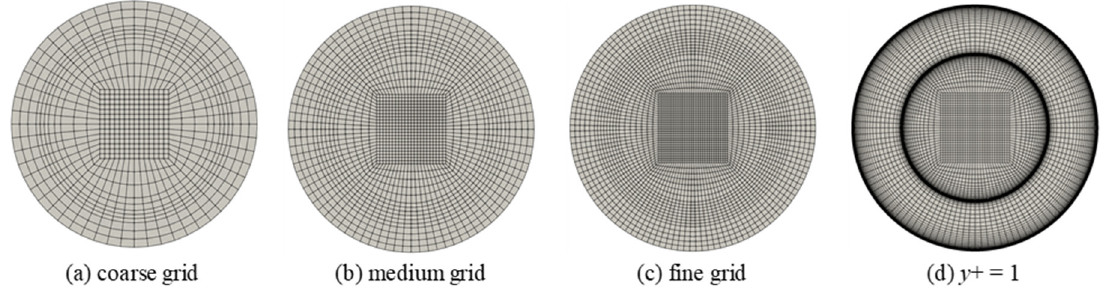
Figure 5. Cross-section view of the four constructed meshes.